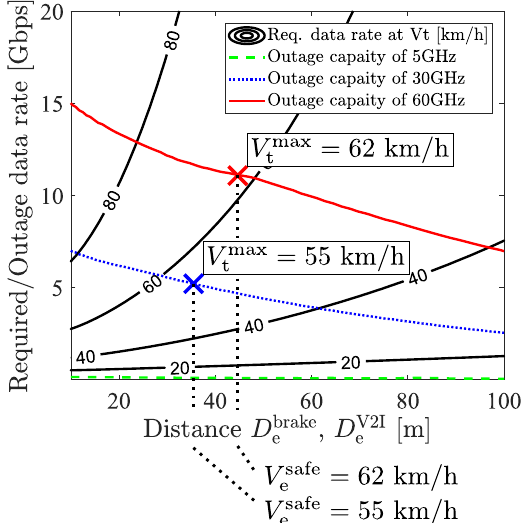
Figure 11. The contour plot shows the required sensor data rate at each V t that adopts comfortable braking and the color lines show the outage capacity realized by each carrier frequency. } realized by each carrier frequency is described by The safe velocity pair { V safe , V safe e t the area below each red, blue, and green line. The velocity values are obtained by reading the contour plot and D e . As D e becomes large, the decrease in the outage capacity and the increase in the required sensor data rate for each V t are read from the figure. The